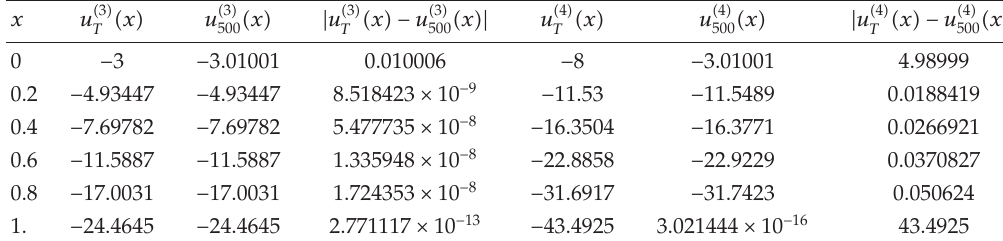
Table 3: The numerical results of Example 3.1.